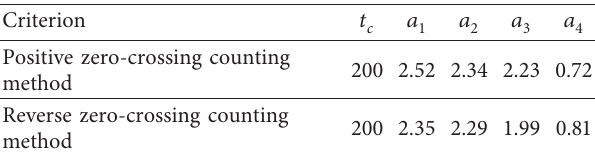
Table 1: Statistical results of freak waves characteristic parameters based on the upper and lower zero-point method when t c � 200s.